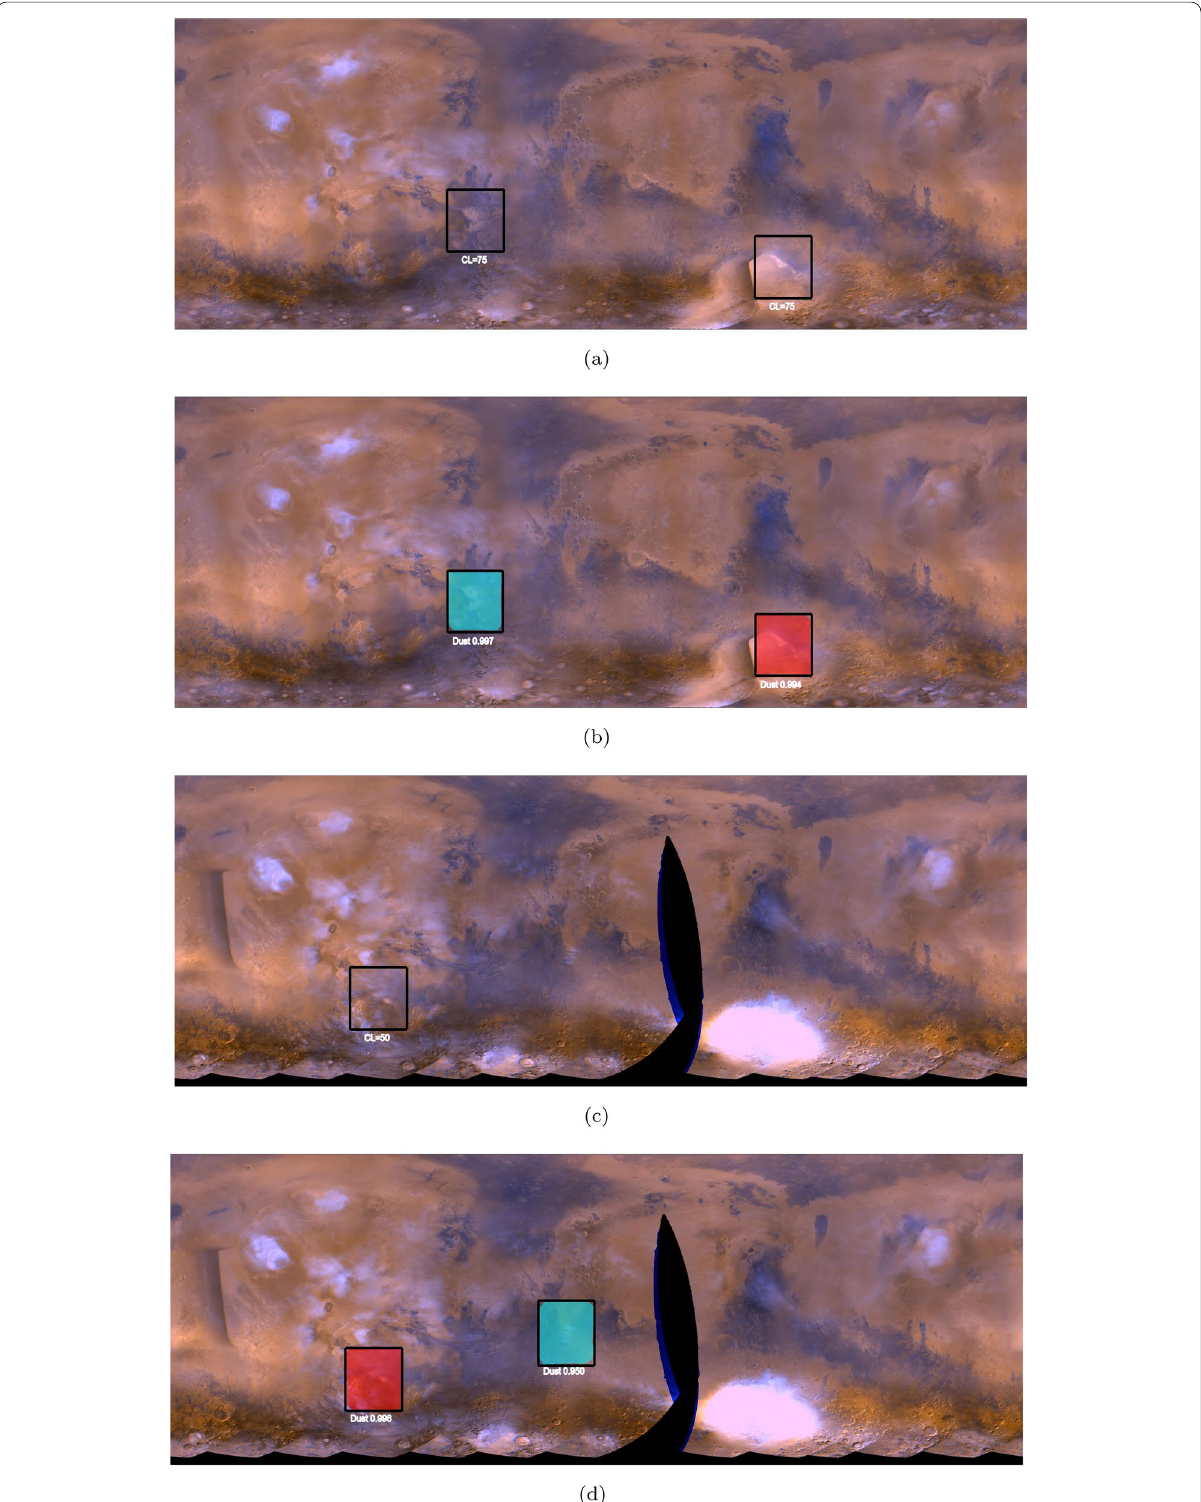
Fig. 5 2nd strategy: the training, validation and testing images are selected randomly from MY 25 to MY 28. a and c are ground-truth images from spring season ( r 18_040 ) at L S = 53.47 ◦ and summer seasons ( r 22_008 ) at L S = 105.36 ◦ , respectively. b and d are their predicted dust